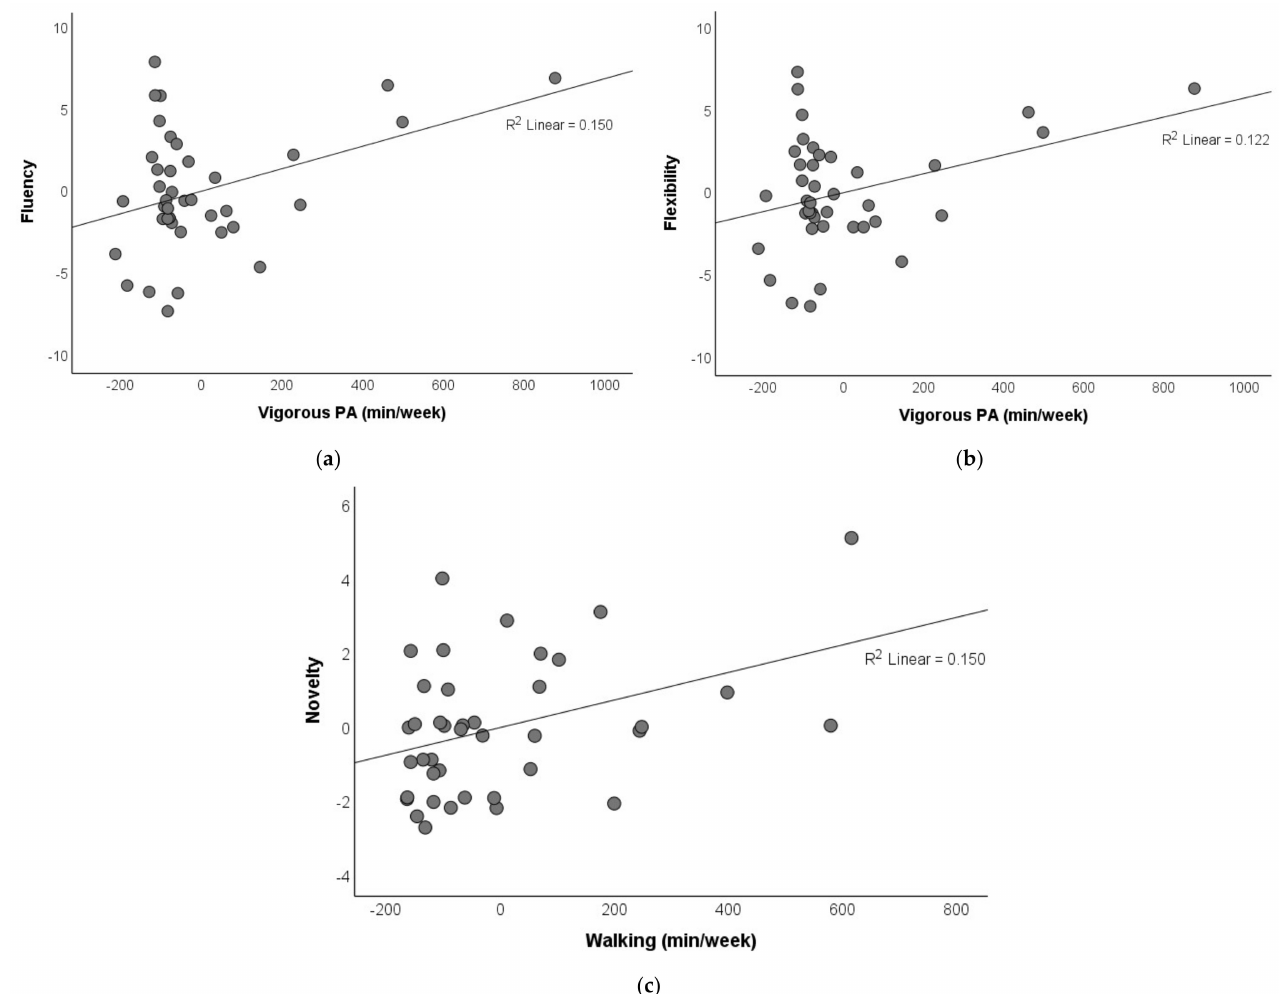
Figure 3. Partial regression plot of the association between different intensities of regular PA and creative thinking at baseline. ( a ) Vigorous-intensity PA and fluency. ( b ) Vigorous-intensity PA and flexibility. ( c ) Walking and